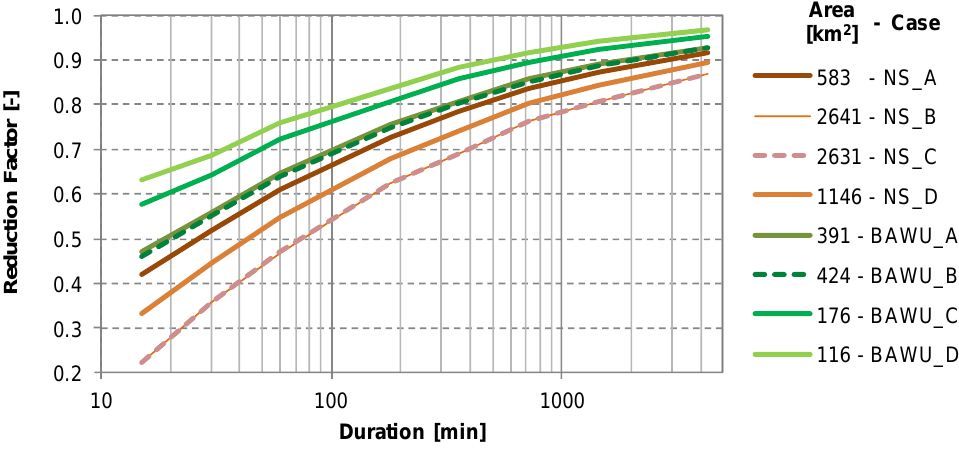
Figure 4. KOSTRA reduction factors for the different case studies.